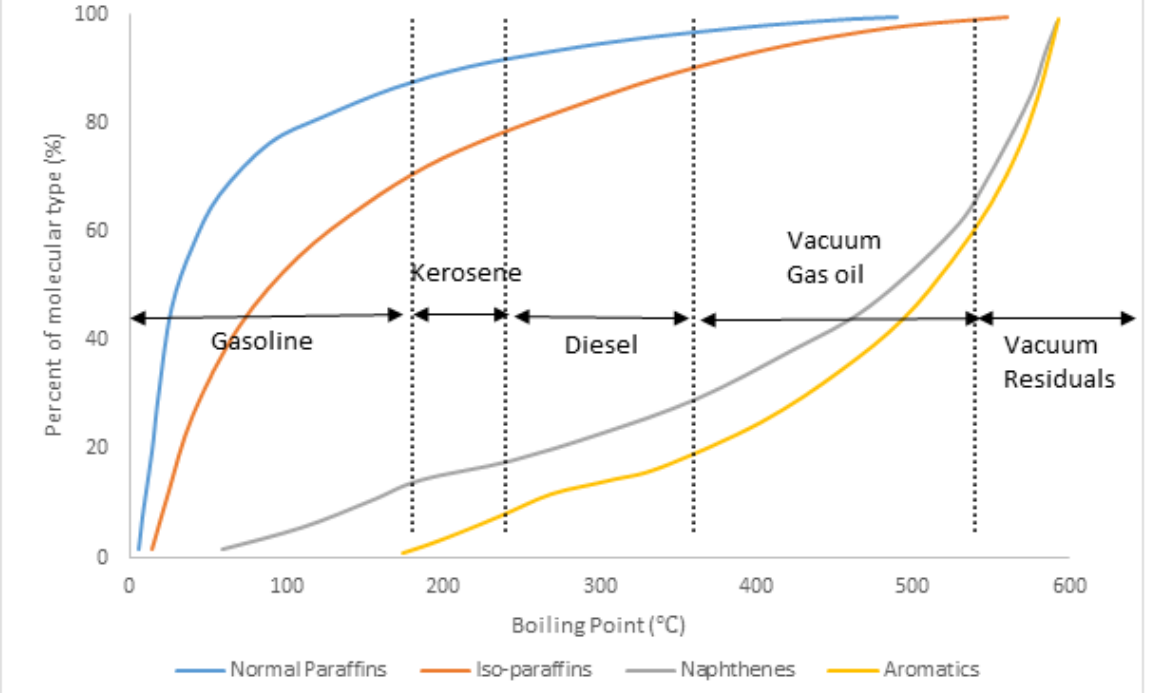
Figure 1. True boiling point (TBP) of a naphthenic crude oil (Redrawn from [44]).